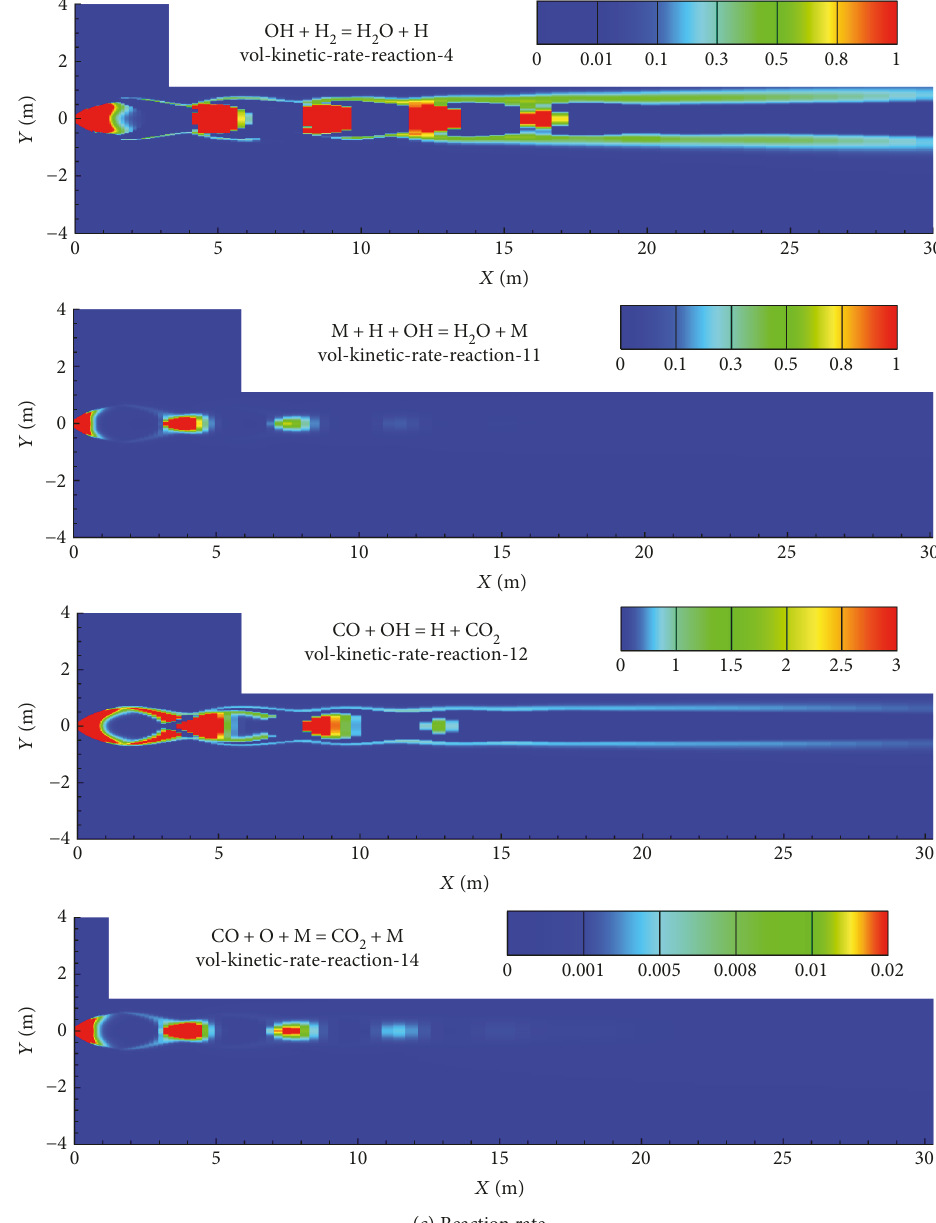
Figure 7: Plume fl ow fi elds of the single-nozzle engine